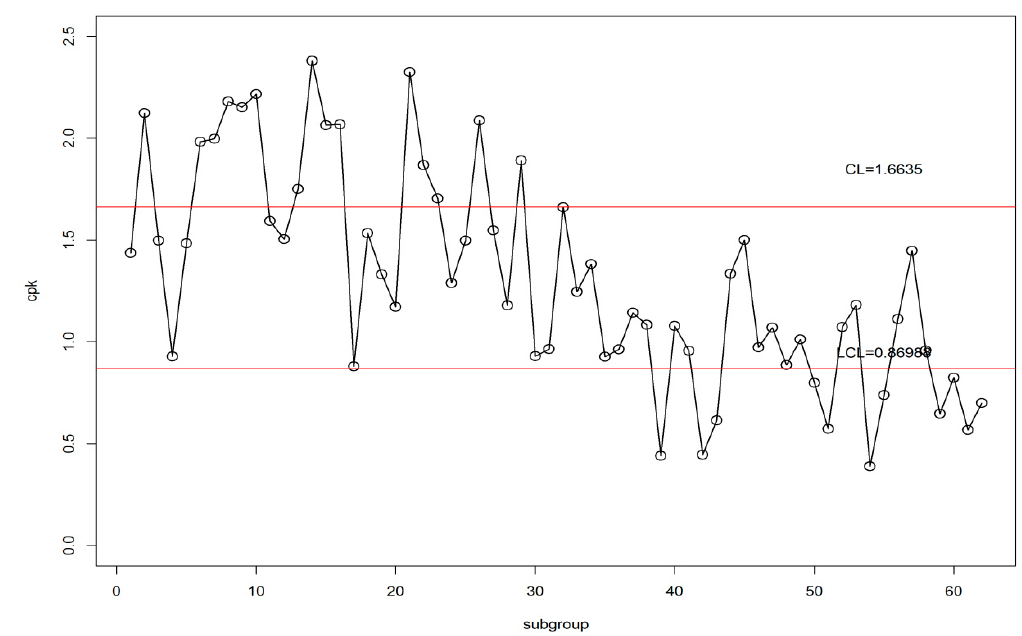
Figure 2. Proposed gamma MAD control chart for simulated data.